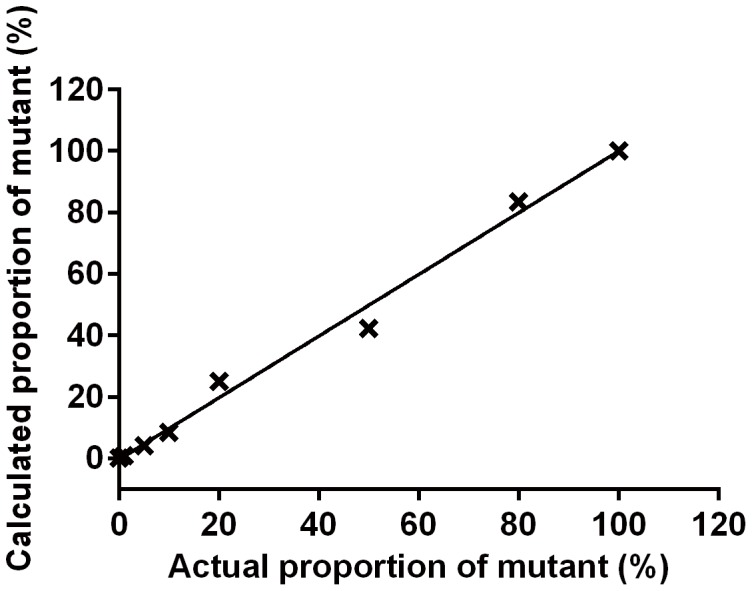
The correlation between actual and calculated proportion of mutant plasmid DNA at the concentration of 1×107 copies/μl.
R2 = 0.9907, P<0.0001.